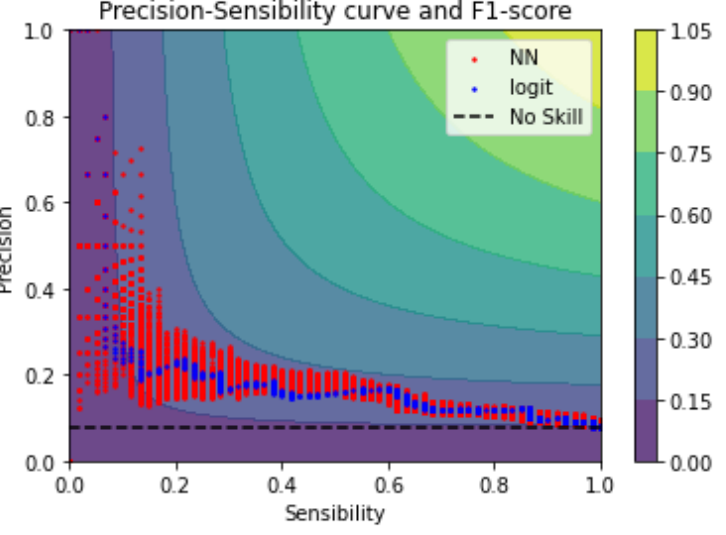
Figure 7. Top 0.1% configurations according to F1 score.